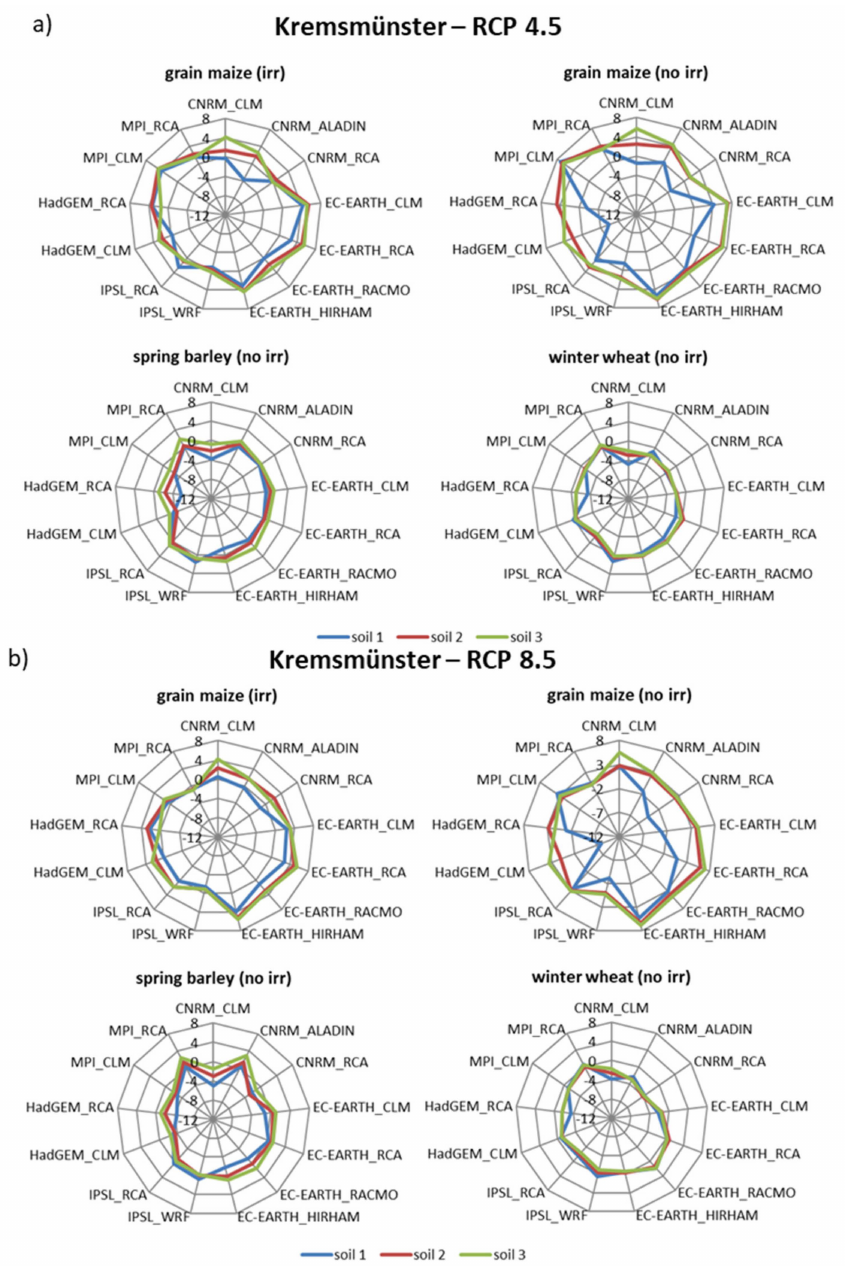
Figure 5. Simulated mean yield differences (with respect to measured weather station data input, as percentages) for grain maize (optimal irrigated = irr; rainfed = no irr), spring barley (no irr), and winter wheat (no irr) grown in the three different soil classes (soil 1 = blue, soil 2 = red, soil 3 = green) for 13 ÖKS projections (( a ) RCP 4.5, ( b ) RCP 8.5) for 1981–2010 at the Kremsmünster weather station